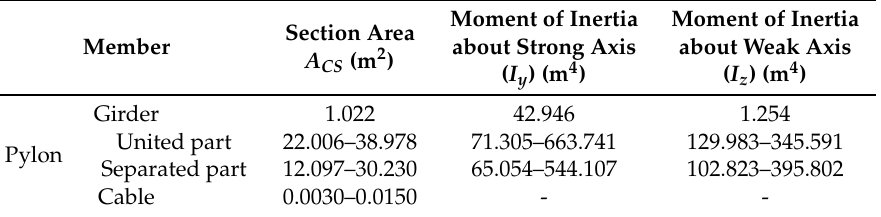
Table 2. Material properties of a bridge.